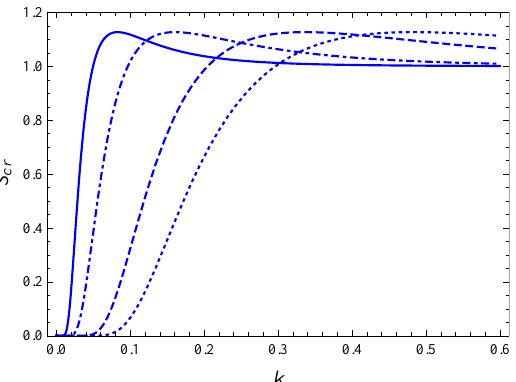
Figure 4. Particle creation entropy, S cr , as a function of momentum k for fixed values a = 1, b = 2, c = 1, λ = 1.5 and the different values of mass m = 0.1 (solid), m = 0.2 (dotdashed), m = 0.5 (dashed), and m = 1 (dotted)